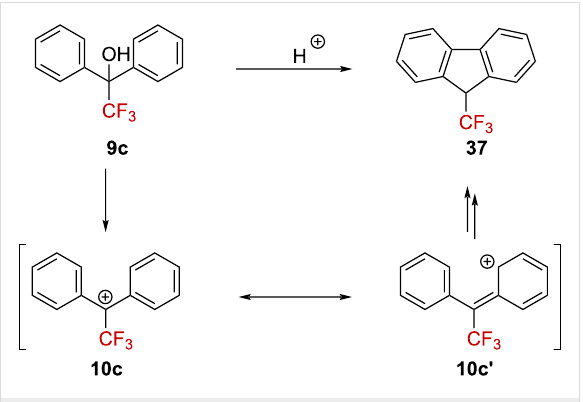
Scheme 8: Reactivity of 9c in the presence of a Brønsted